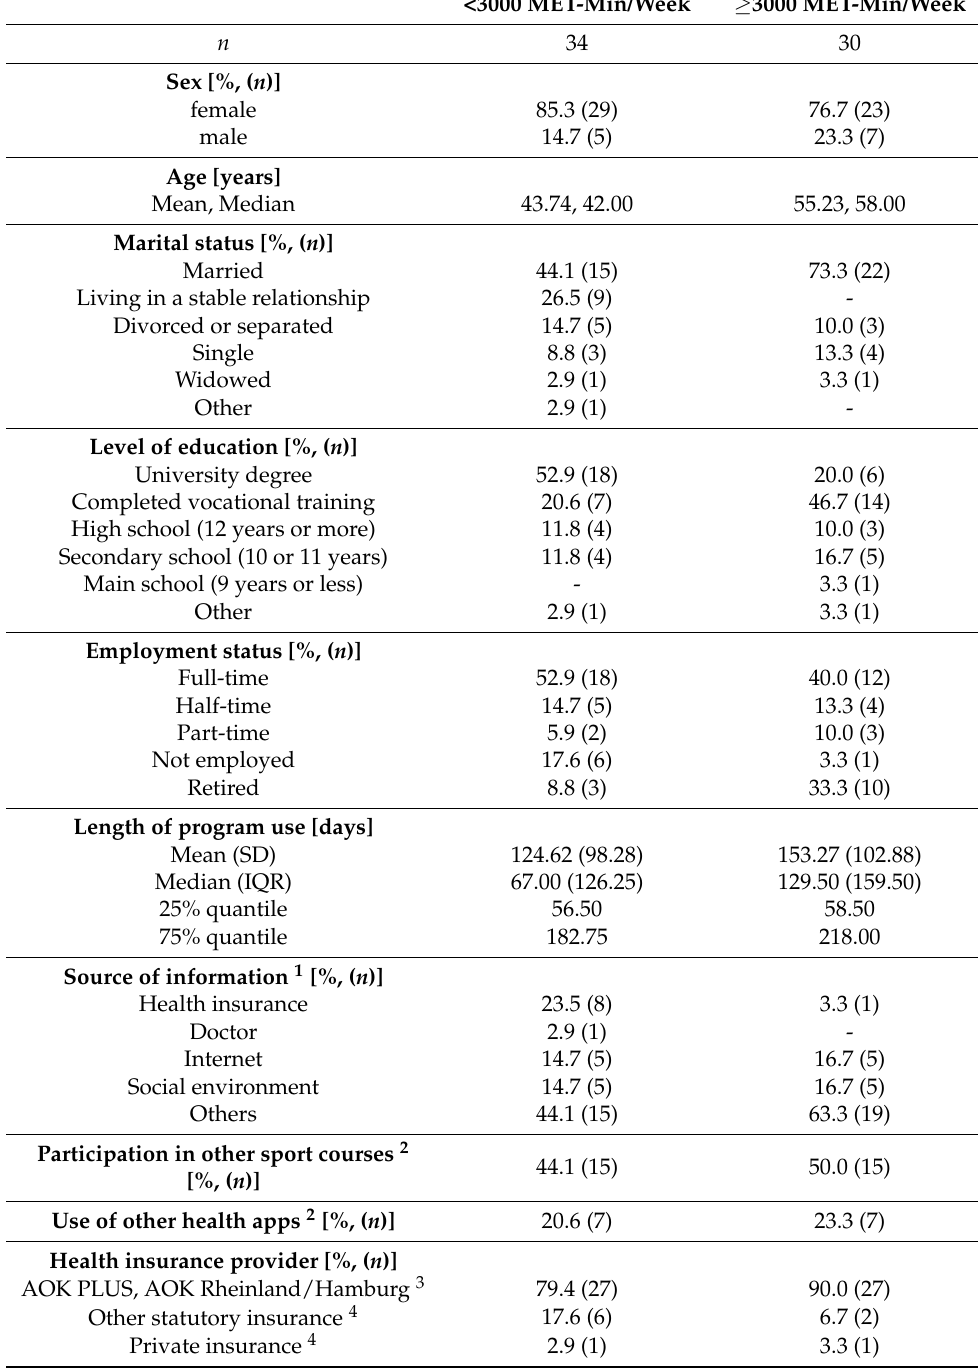
Table A2. Characteristics of the study participant with different baseline activity